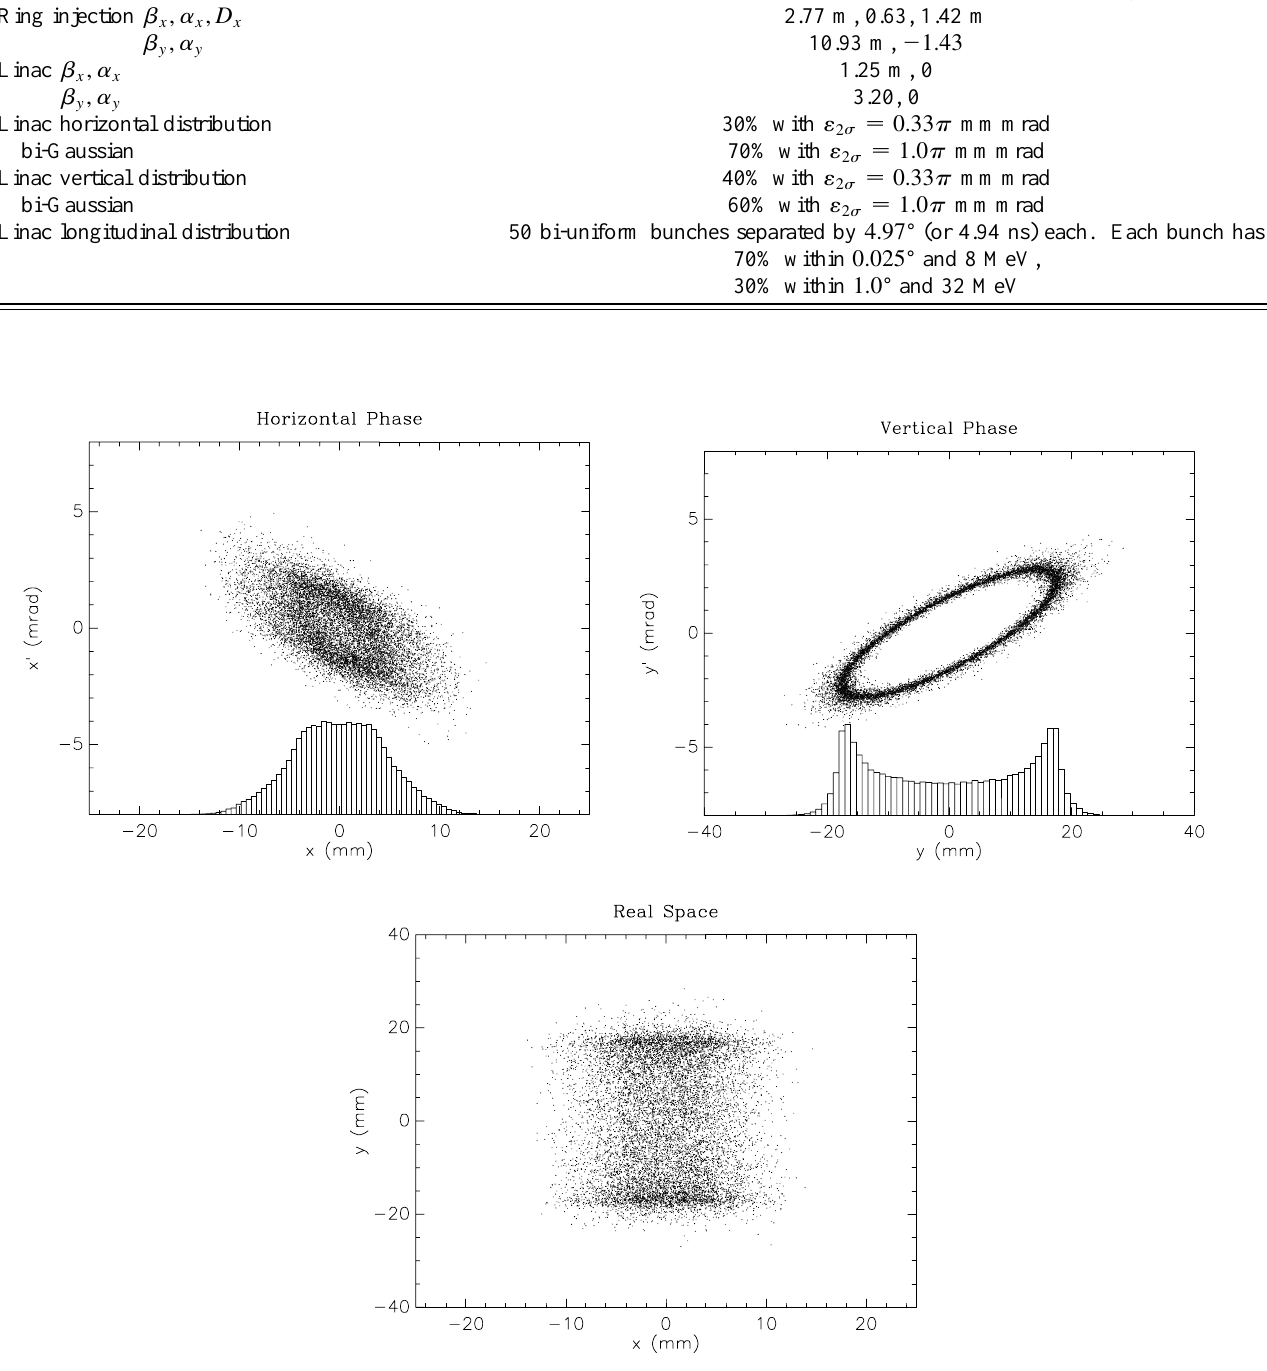
FIG. 1. Calculated phase space distributions at the end of injection, for the case with no vertical bump during injection and no space